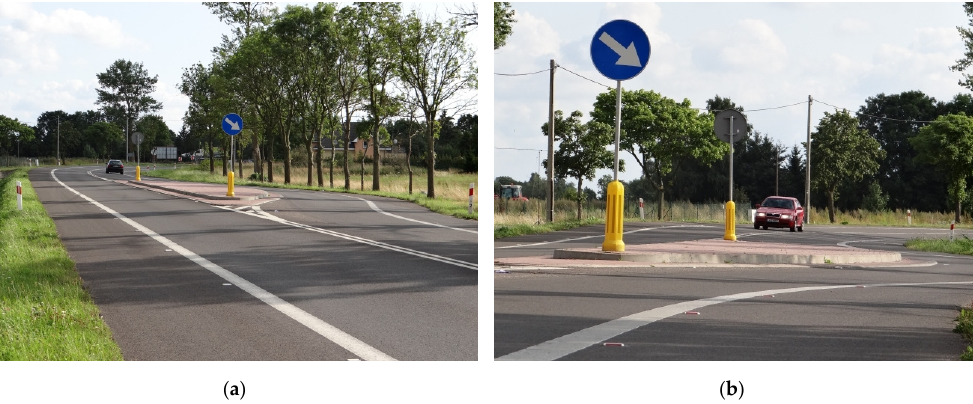
Figure 23. Example of semi-circular chicane horizontally deflecting one carriageway lane: ( a ) overview; ( b ) visible details of the semi-circular chicane island.